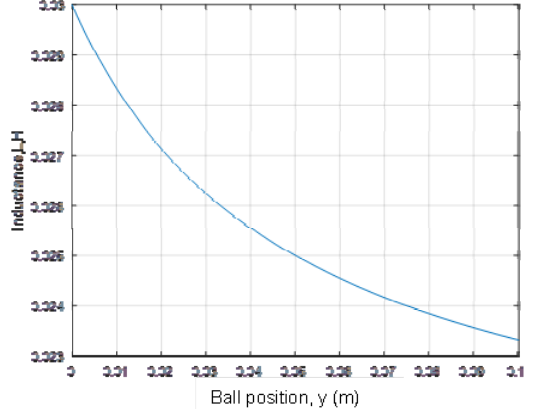
Figure 2: Electromagnetic inductance vs. ball position.